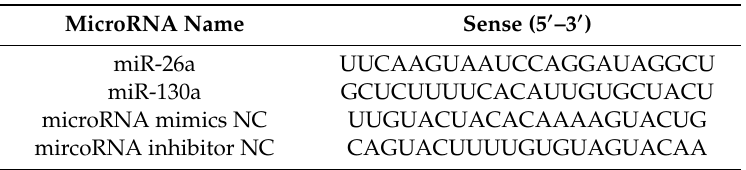
Table 2. The mimics and inhibitors